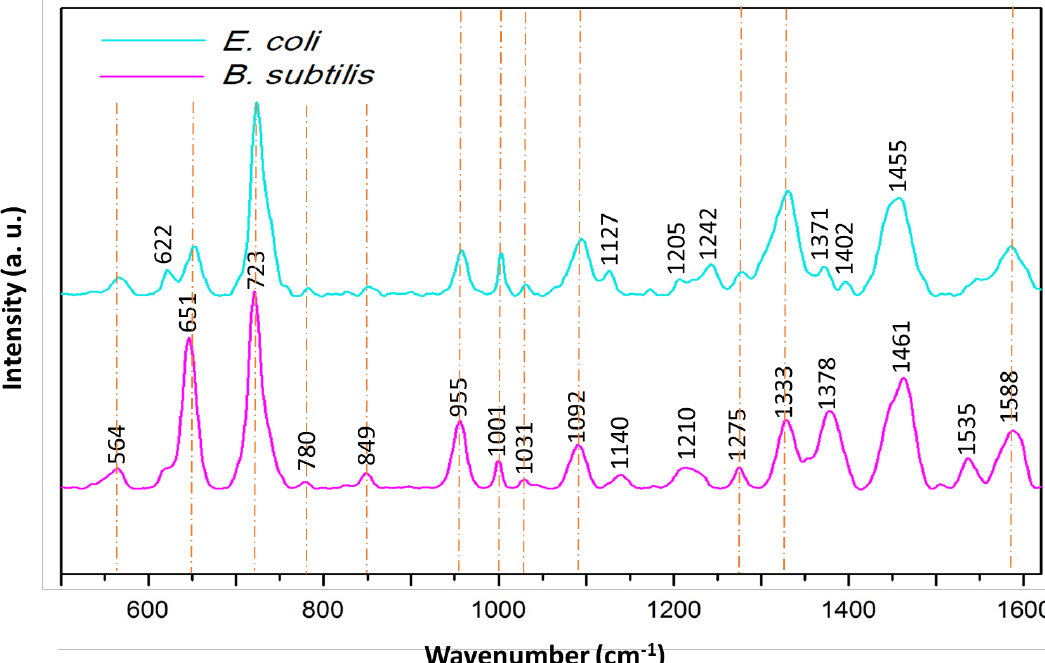
Figure 7. Average SERS spectra E. coli (turquoise) and B. subtilis (pink) recorded on Ag/SSWM (mesh 80 × 800 covered with 50 nm layer of Ag) SERS platforms. For all spectra, excitation wavelength was at 785 nm, laser power was 5 mW, and acquisition time was 30 seconds. Each SERS spectrum of examined bacteria was averaged from 30 measurements in different places across the SERS surface using mapping mode.